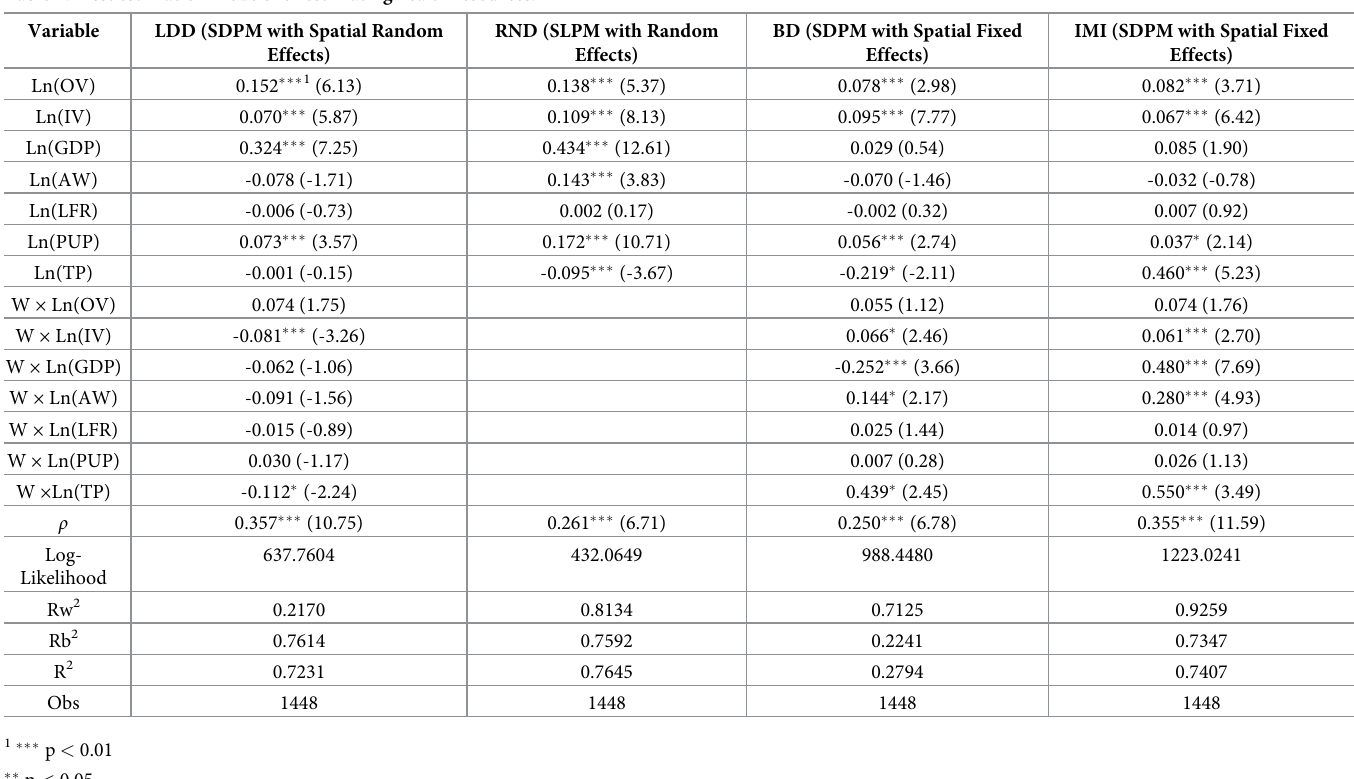
Table 4. Best estimation models for estimating health